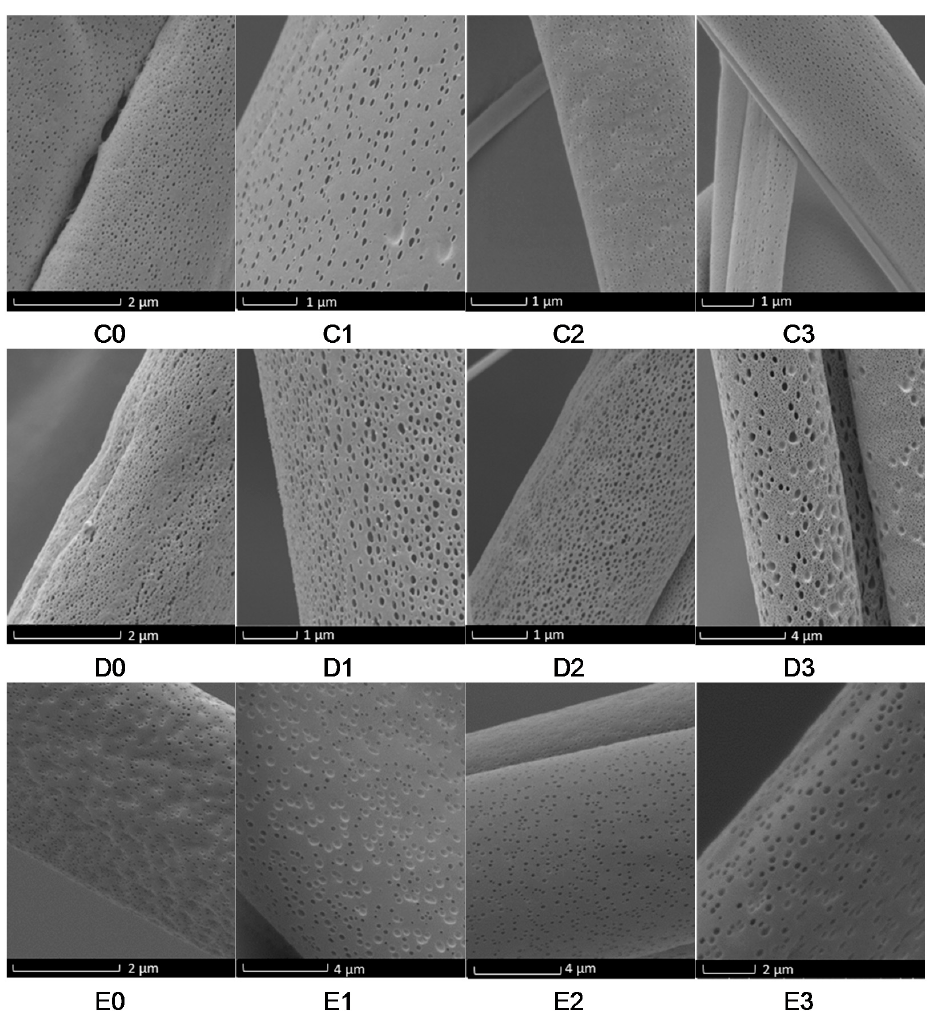
Figure 4. Higher magnification scanning electron micrographs of PMMA fibers prepared using different solvents and different working pressure: ( C0 – C3 ) fibers made using chloroform 0, 0.1, 0.2, 0.3 MPa working pressure, respectively; ( D0 – D3 ) fibers made using DCM 0, 0.1, 0.2, 0.3 MPa working pressure, respectively; ( E0 – E3 ) fibers made using ethyl acetate 0, 0.1, 0.2, 0.3 MPa working pressure, respectively.